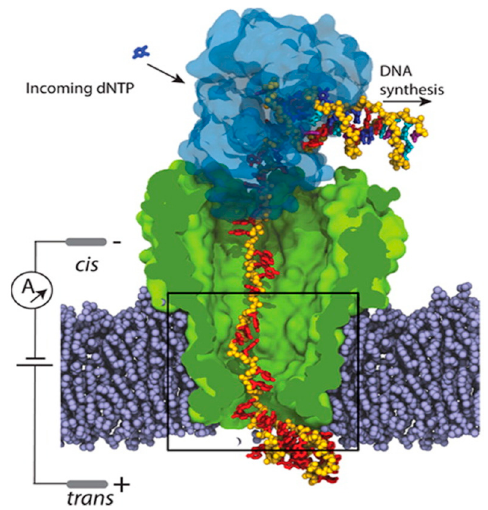
Figure 6. Molecular dynamics simulations of blockade currents in biological nanopores: All-atom model of MspA (green) suspended in a lipid bilayer membrane (purple spheres). A phi29 polymerase (blue semitransparent surface) is bound to the junction of single- and double-stranded DNA (the DNA backbone is represented by the yellow spheres [132]. The water molecules and ions are not shown in either figure.